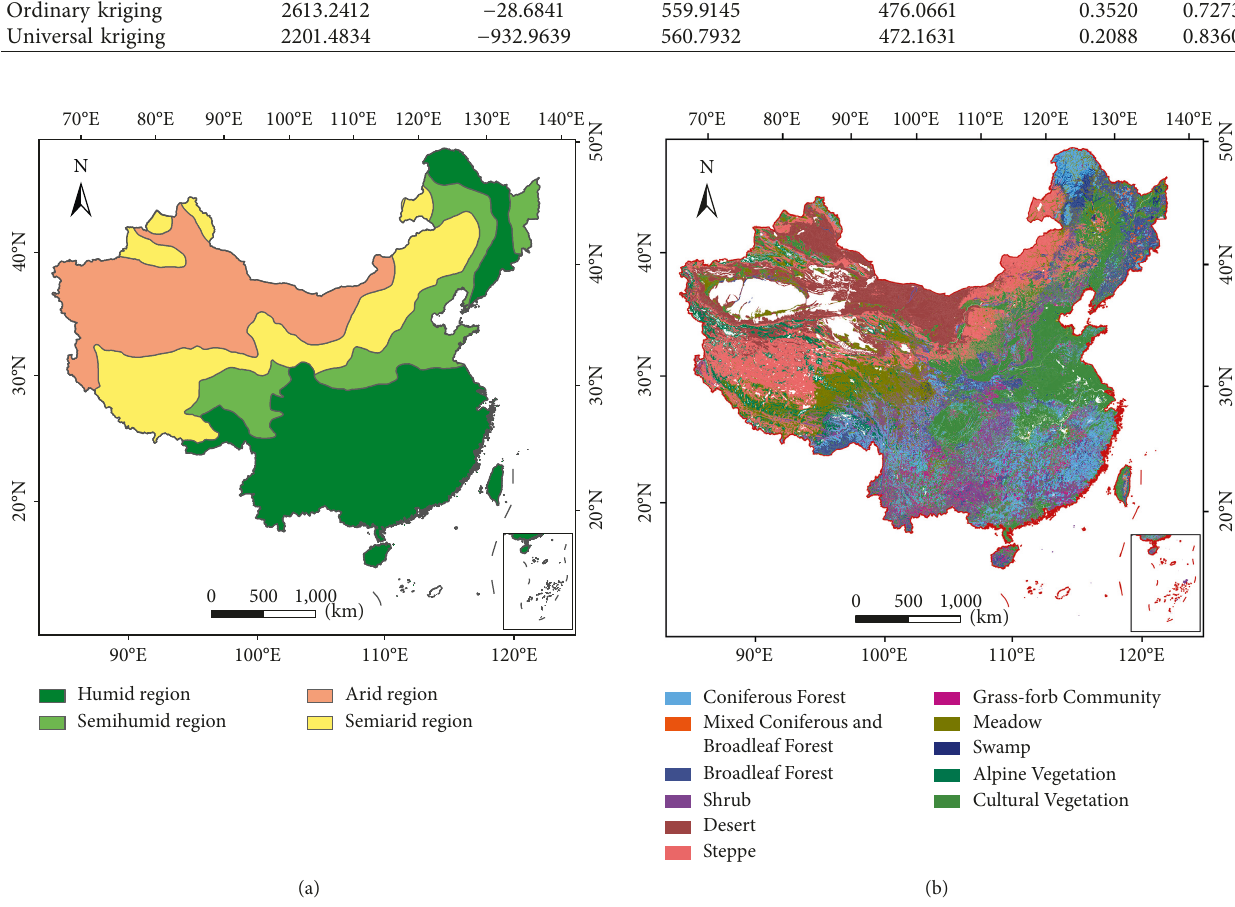
Figure 1: The maps of (a) arid and humid climate zones and (b) vegetation types in